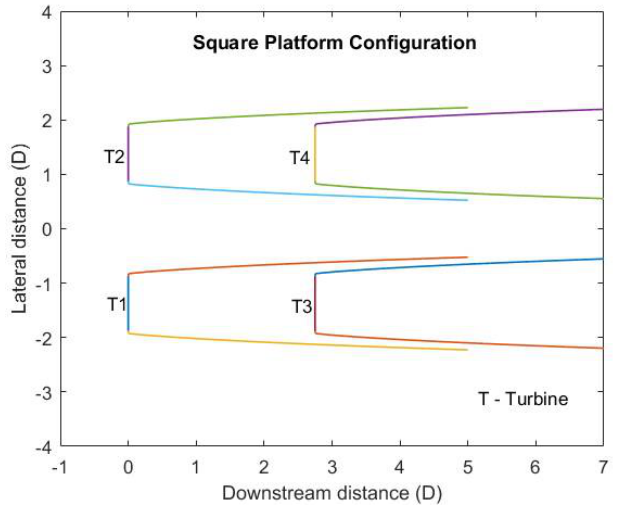
Figure 1. Wake propagation for a square platform.